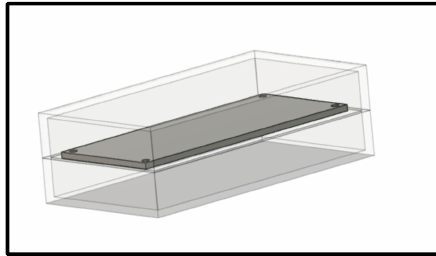
Figure 13. Model board used to form a basic structure of the enclosure.